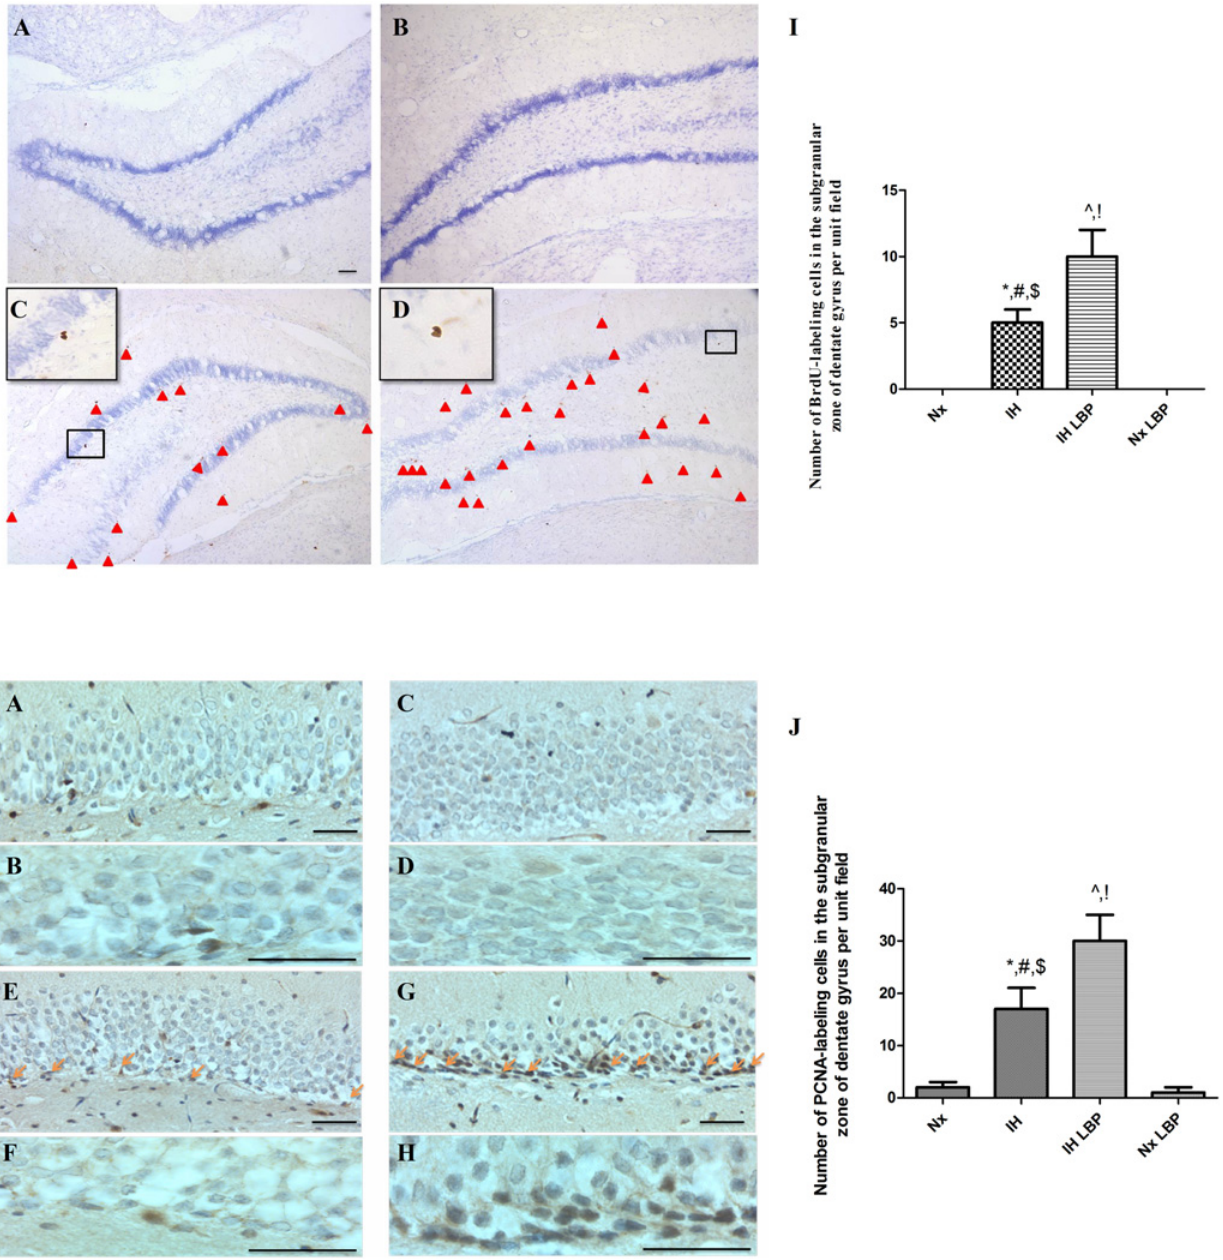
Fig 11. LBP enhanced CIH-induced proliferative activities in the hippocampus. Panels A and B summarize the number of positive BrdU- or PCNA- staining cells in the SGZ of dentate gyrus in the hippocampus among different groups. Data are mean ± SEM (n = 6 – 8). * p < 0.05 when compared with Nx, # p < 0.05 when compared with IH+LBP, $ p < 0.05 when compared with Nx+LBP groups, ^ p < 0.05 when compared with Nx, ! p < 0.05 when compared with Nx+LBP. Magnification: 10× and 40× (BrdU), Scale bar: 100 μ m; 40× and 100× (PCNA), Scale Bars: 50 μ